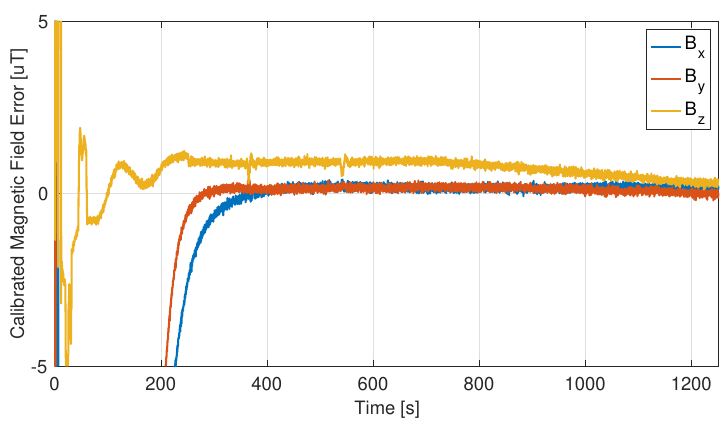
Figure 16. Magnetic field calibration